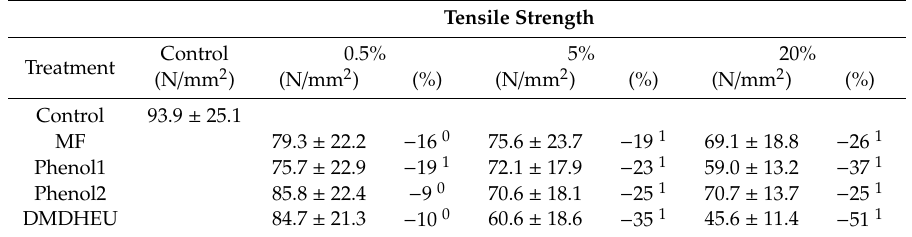
Table 6. Tensile strength (N / mm 2 ) and change compared to control (%) depending on the modification agent and the concentration (mean ± SD).